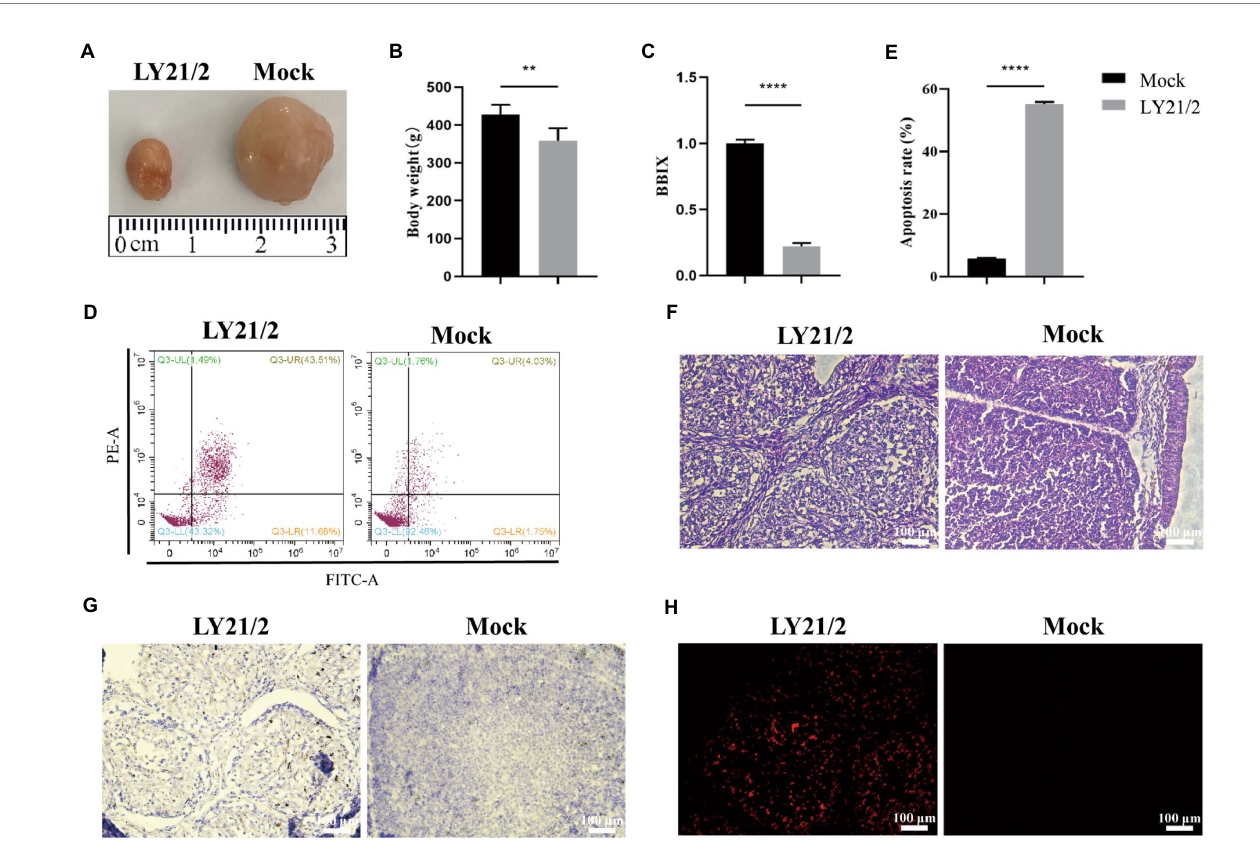
FIGURE 4 Pathogenicity of the novel variant IBDV strain LY21/2. 3-week-old SPF chicks were inoculated with the IBDV strain LY21/2 and euthanatized at 10 days post- infection. Bursal atrophy was observed in infected chick (A) .The mean body weight (B) and the BBIX values (BF:body weight index) (C) of LY21/2-infected chicks were both negatively influenced. The apoptosis rates of bursal cells of two groups were detected, and the mean rate of LY21/2-infected cells were 49.46% higher than that of mock-infected cells (D,E) . ** p < 0.01, **** p < 0.0001; an unpaired t -test was used to compare differences between the LY21/2- infected and mock-infected group. (F) Histological observation of bursal tissues from the mock- and LY21/2-infected chicks. The bursal section of the mock-infected group showed no apparent histological lesions. However, lymphocyte depletion and connective tissue hyperplasia were observed in the bursa of LY21/2-infected chicks. Arrows indicate atrophy of the follicle and lymphocyte depletion in the bursa. Empty triangle indicates a proliferation of connective tissue. (G) IHC staining of bursal tissues from the non-infected and infected chicks. No staining was observed in the bursal tissue from non- infected chicks. The bursal sample of LY21/2-infected chicks showed IBDV antigen-positive cells using the anti-VP2 monoclonal antibody. (H) TUNEL staining of bursal sections. Infection of LY21/2 induced DNA fragmentation in apoptotic bursal cells (red), whereas, positive signal was hardly detected in normal bursal cells. Scale bar, 100 μ